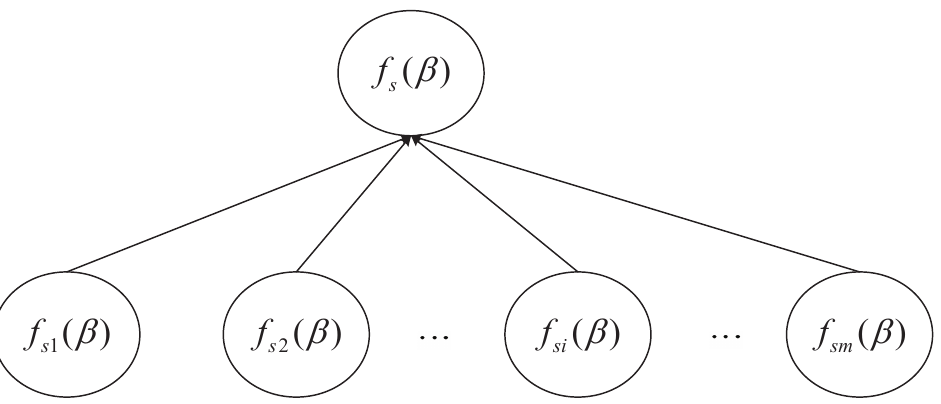
Figure 2. General organization. The link between the local model f si ( β ) and the global model f s ( β ) is depicted in the picture. A big data collection may be broken up into smaller subsets, each of which is made up of s = { s 1 , s 2 · · · s m } , and m submodels that are derived from each subset.